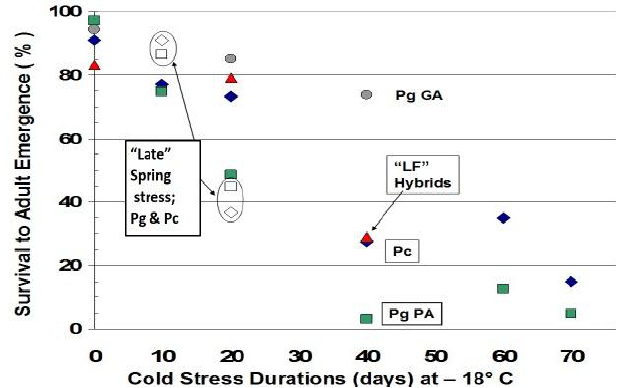
Figure 6. The pupal survival to adult emergences of P . canadensis , P . glaucus and Late-flight (LF) hybrids exposed at (cid:237) 18 °C for 10, 20, 40, 60, or 70 days in mid-winter. The normal winter control treatment (0 days at (cid:237) 18 °C) was at +4 °C in darkness. The number of survivors for each treatment shown here includes males and females together. Also, for comparison, a subset of these P . g . and P . c . were exposed to the cold stress just 10 or 20 days before being brought out of diapause in the late Spring (instead of mid-winter). Note that P . canadensis survival was better than P . glaucus at all durations greater than 20